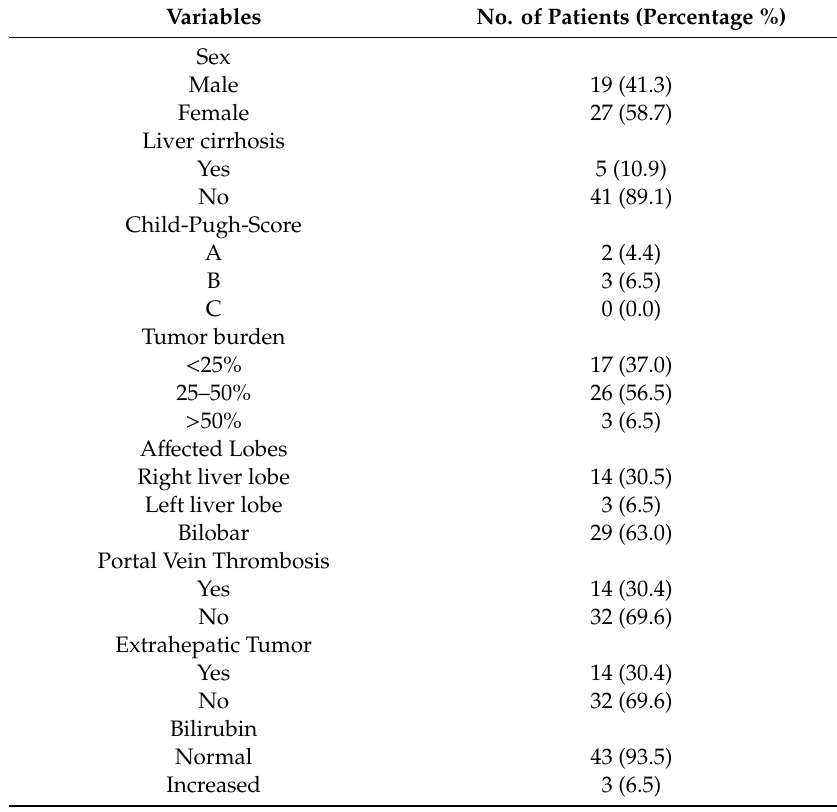
Table 1. Baseline patient